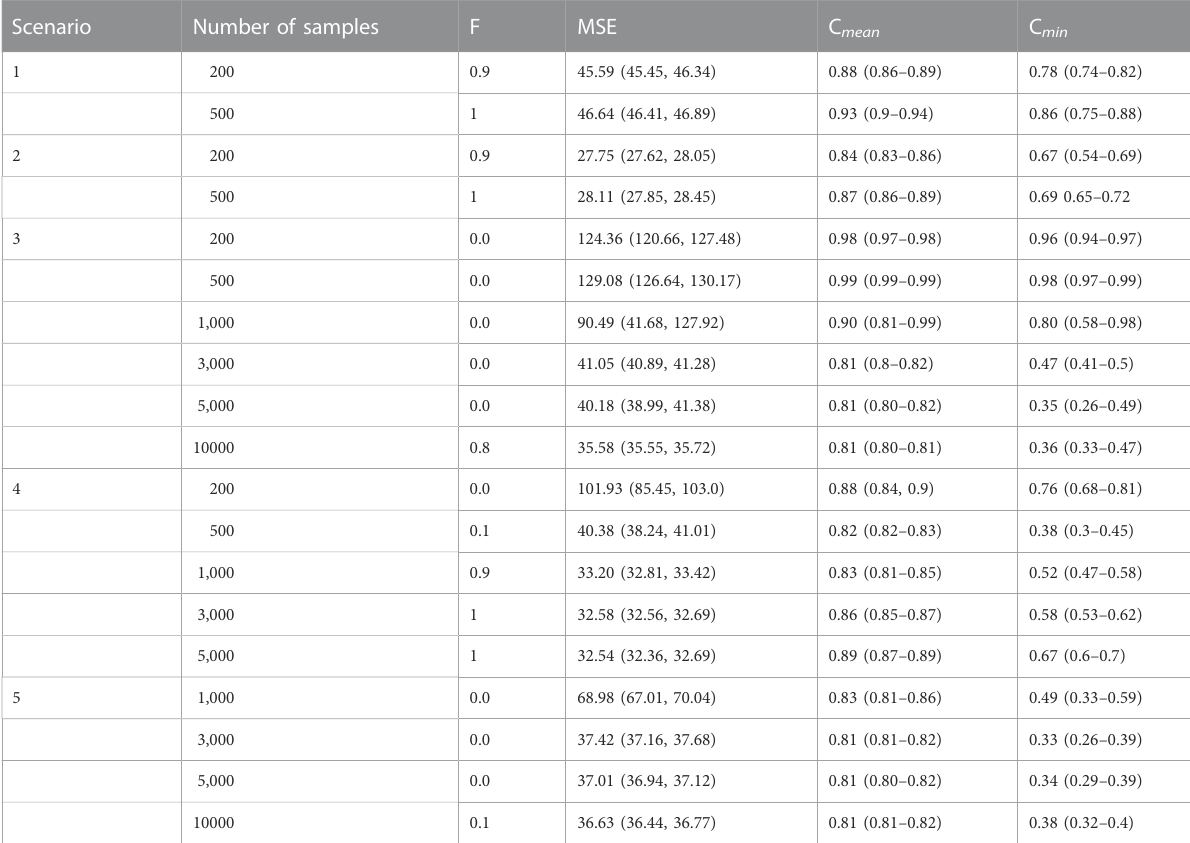
TABLE2 Denovo signatureextractionperformance.Foreachsimulatedscenario,thefrequencyofrunswithallthesignaturescorrectlyidenti fi edF),themean squareerror(MSE)betweensimulatedandreconstructedcatalogues,theaverage C mean andminimum C min